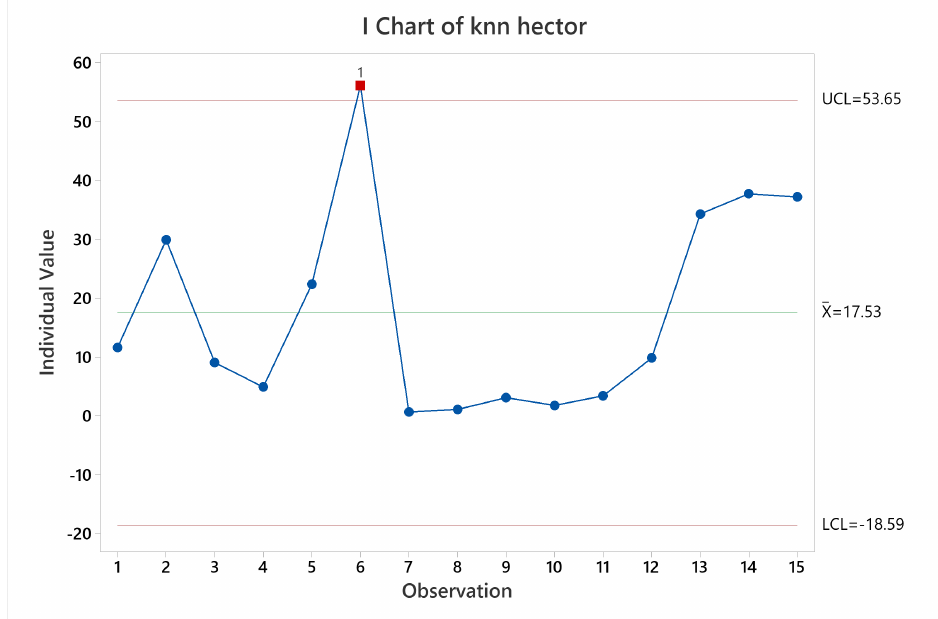
Figure 21. Map accuracy mean behavior for HECTOR-SLAM.